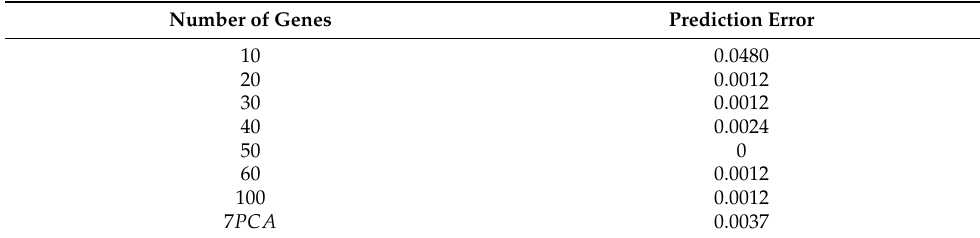
Table 3. Estimated prediction error rate by 5-fold cross-validation with 1-nearest neighbor